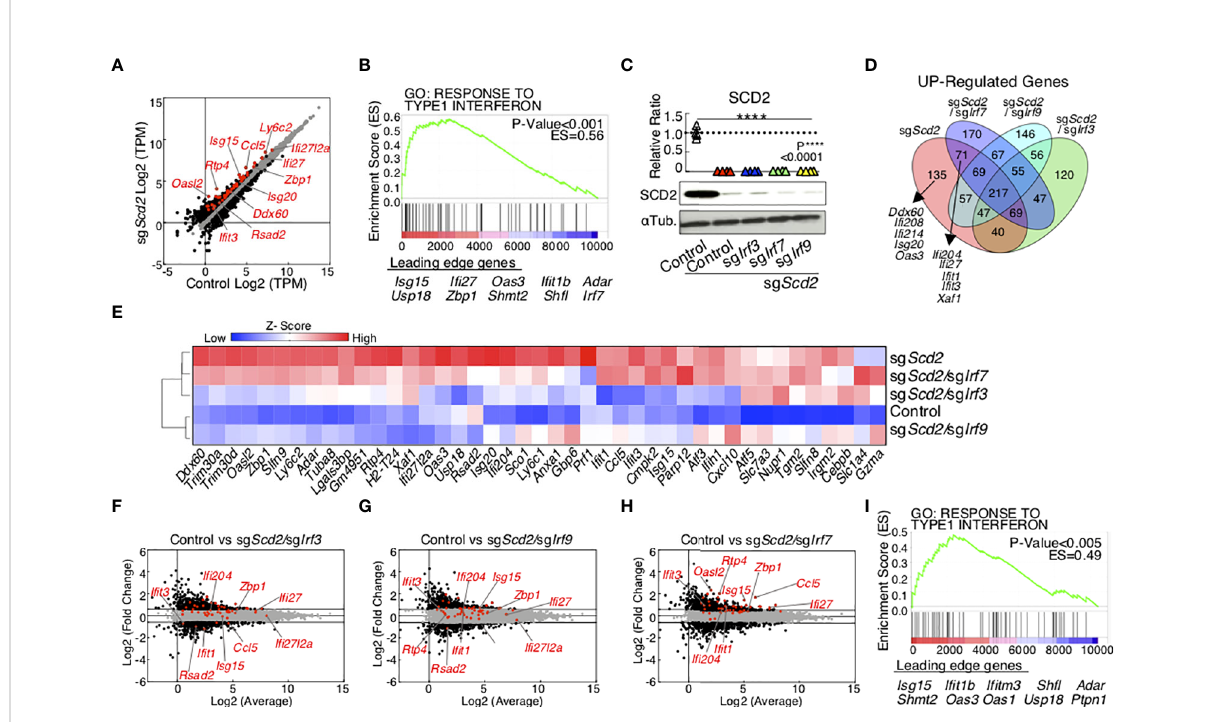
FIGURE 1 The transcriptome of ISGs in sgScd2 Th1 cell depends on IRF3 and IRF9, but not IRF7. (A) A scatter plot of gene expression by RNA-sequencing (n=5 per sample) compares in control and sgScd2 Th1 cells. The genes with over 1.5-fold changes are marked with black dots, and ISGs are marked with red dots (Control, n=5; sgScd2, n=5 biologically independent sample). (B) GSEA reveals the upregulation of the ISGs in sgScd2 Th1 cells. Genes are ranked into an ordered list on the basis of fold change in control and sgScd2 Th1 cells. Genes below the picture indicate leading edge subset. ( C ) Western blot analysis of SCD2 from control, sgScd2, sgScd2/sgIrf3, sgScd2/sgIrf7 and sgScd2/sgIrf9 Th1 cells. The summary of relative intensity was shown. Band intensity was determined by image j. (D) The Venn diagram showed overlaps and differences between 1.5-fold increased genes in sgScd2, sgScd2/sgIrf3, sgScd2/sgIrf7 or sgScd2/sgIrf9 Th1 cells compared to control Th1 cells. (E) A heat map depicts the gene relevant to (B) . (F – H) A scatter plot of gene expression by RNA-sequencing (n=5 per genotype) compares sgScd2/sgIrf3 (F) , sgScd2/sgIrf9 (G) or sgScd2/sgIrf7 (H) Th1 cells against control Th1 cells. (I) GSEA reveals the upregulation of the ISGs in sgScd2/sgIrf7 Th1 cells. Genes are ranked into an ordered list on the basis of fold change in control and sgScd2/sgIrf7 Th1 cells. Genes below the picture indicate leading edge subset. Three experiments were performed and showed similar results (C) . Data represent mean ± SD (one-way ANOVA test followed by Tukey ’ s post-hoc test for multiple comparisons,